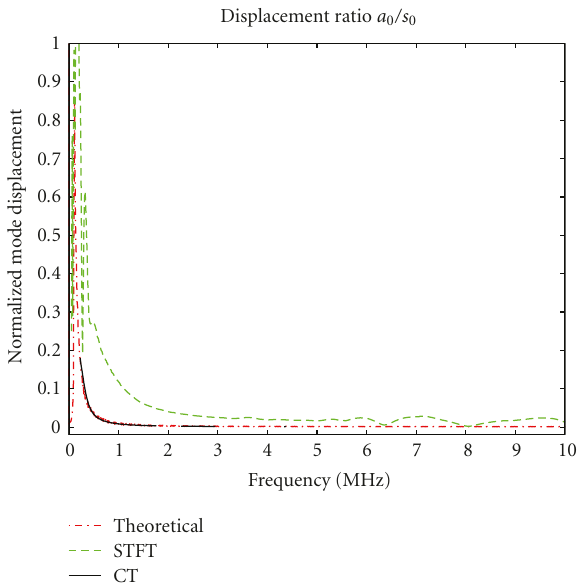
Figure 2: Out-of-plane displacement ratio of mode s 0 normalized to mode a 0 for the synthetic signal. Figure 3: Geometric attenuation for the a